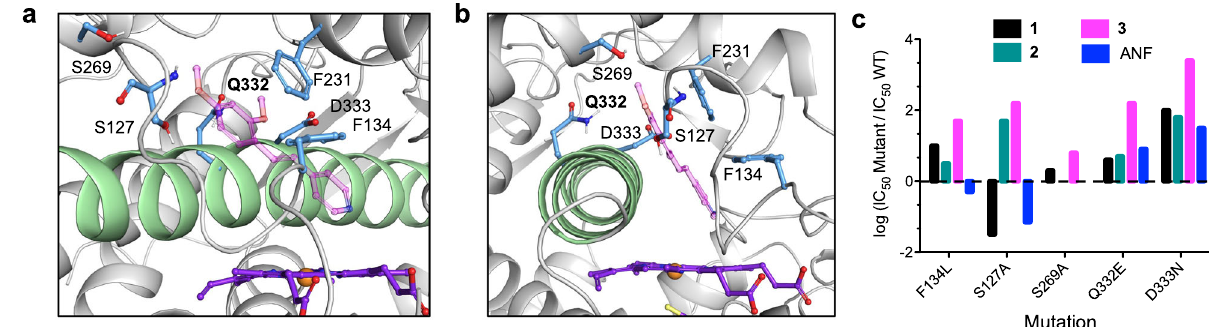
Fig. 3 Mutations reveal key contacts in CYP1B1. a , b Location of mutated amino acids. The I-helix is shown in green, the heme in purple, and 3 (lavender) was docked in the structure. Q332 (bold) is not found in other CYP1 family members. F231 is essential for turnover of the REE substrate. c Effect of point mutations on the ef fi cacy of CYP1B1 inhibitors. The inhibitors were less potent in the mutants, with the exception of ANF and 1 in the S127A mutant and ANF in the F134L mutant. The log of the ratio of IC 50 values was used to simplify visualization. See Supplementary Table 2 for